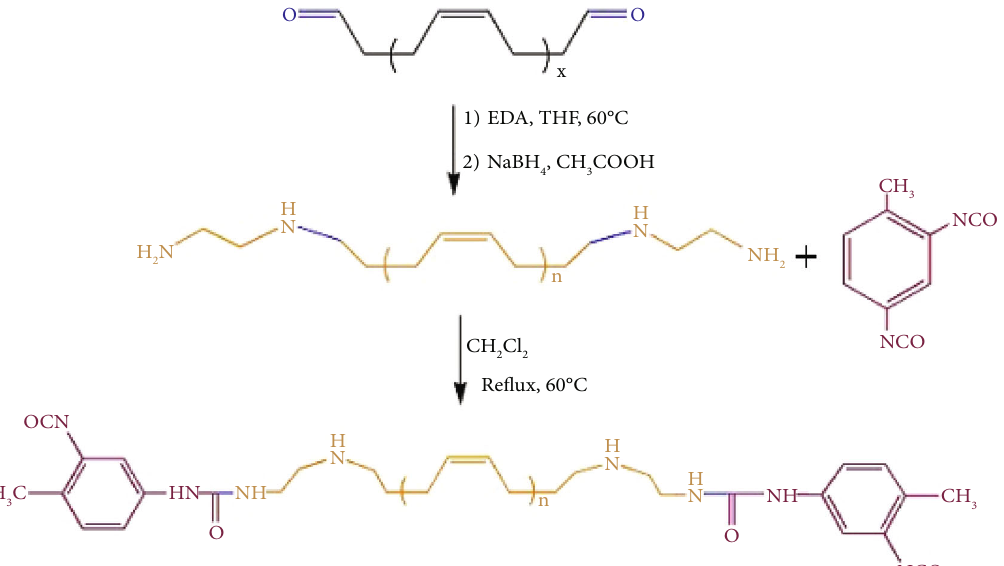
Scheme 2: Synthesis of polyurea fi